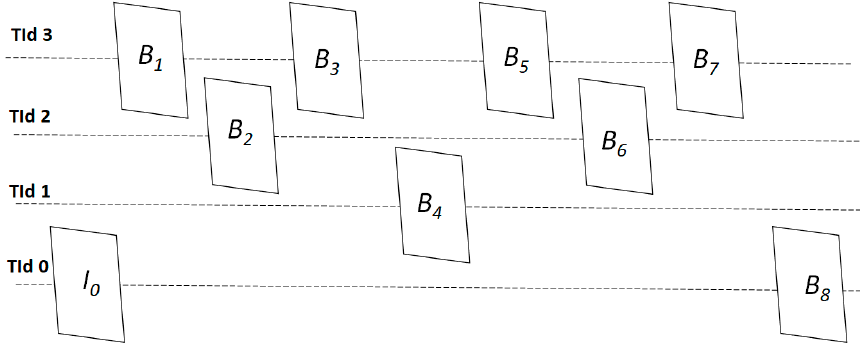
Figure 5. Tid illustration with HEVC Random Access configuration .